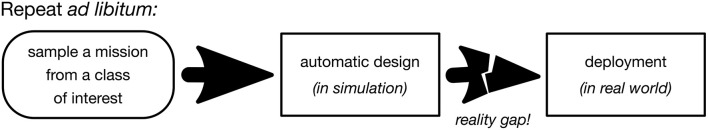
Flowchart diagram of the automatic off-line design process. A mission is sampled from a class of interest. Using computer-based simulations, an automatic design method defines a robot swarm tailored to the mission sampled. Once the automatic design terminates, the swarm is deployed in the target environment and has to cross the so-called reality gap—the possibly subtle but inevitable difference between simulation and reality (Brooks, 1992; Jakobi et al., 1995)—which is among the most challenging issues in automatic off-line design. The process is repeated ad libitum. It should be noted that an automatic design method could generate a robot swarm from scratch for every mission sampled or could refine and adapt a solution previously generated for a similar one. It could also, for example, produce a robot swarm by combining and modifying solutions (or partial solutions) contained in a catalog of template solutions that were pre-defined by a human expert. The only condition that needs to be respected for the process to be qualified as automatic off-line design is that such initial (partial) solutions must be selected without any per-mission human intervention and without recourse to tests performed in the target environment.